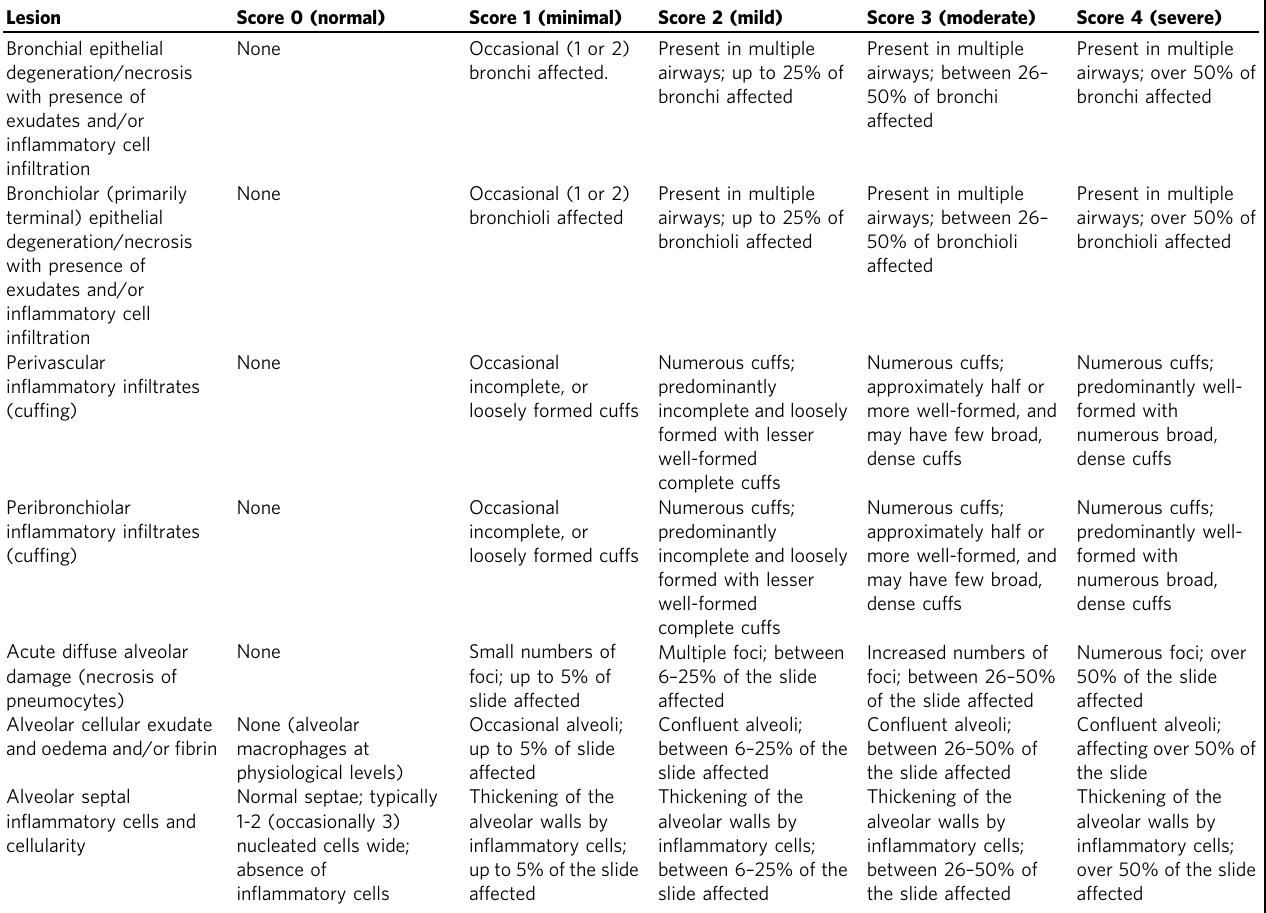
Table 1 Pulmonary histopathology scoring system. Lesion Score 0 (normal) Bronchial epithelial degeneration/necrosis with presence of exudates and/or